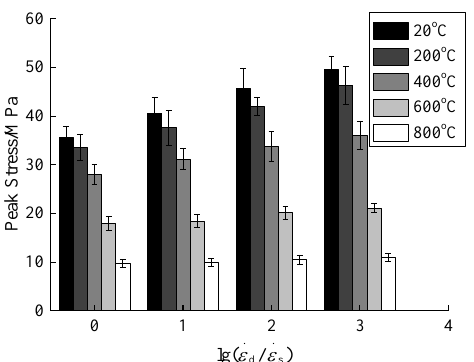
Figure 10. Relationship between strain rate and concrete compressive stress.